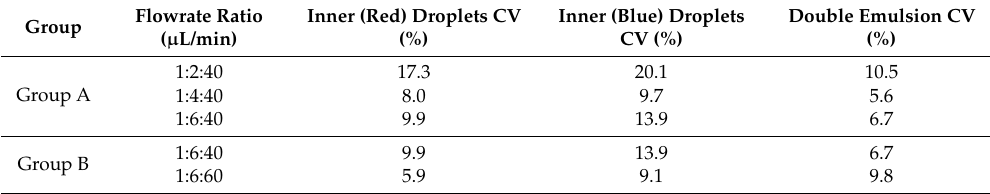
Table 4. Coefficient of variance for different types of droplets at each flowrate ratio.